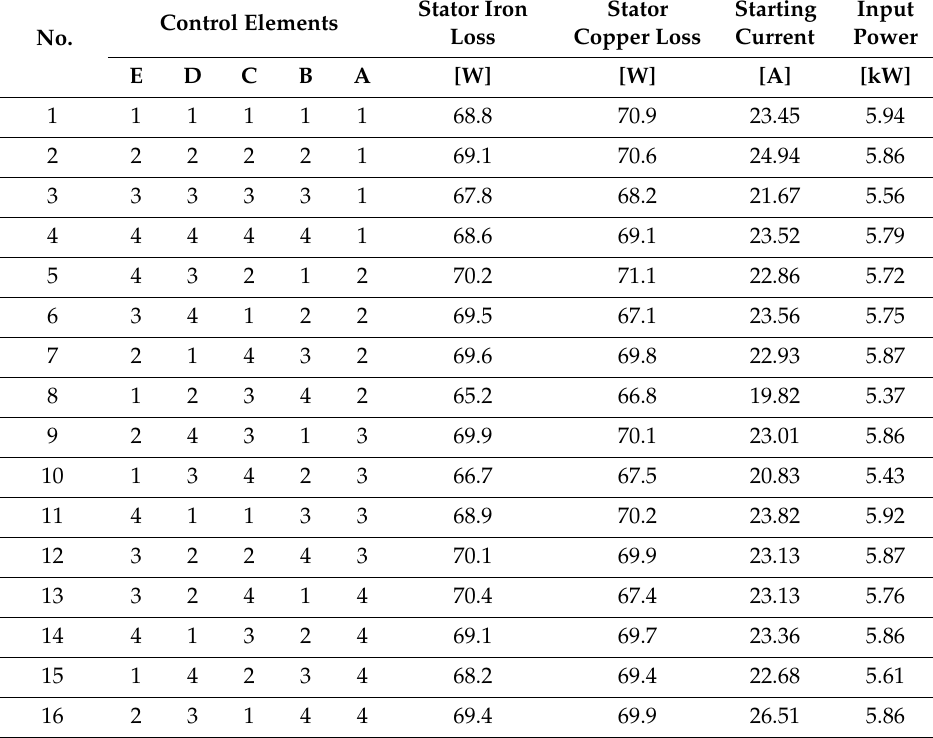
Table 2. Orthogonal array L16 matrix by the Taguchi method and performance